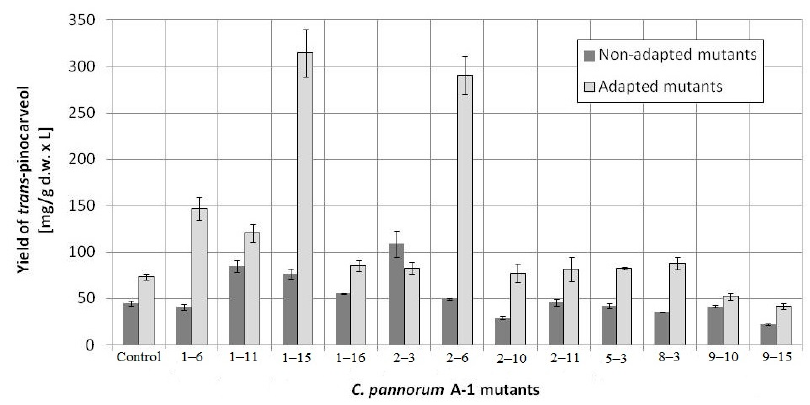
Figure 2 . Effect of mutagenesis and adaptation to the substrate β -pinene on the biotransformation yield of 12 most active mutants of C. pannorum A-1. Non-treated parental strain and parental strain adapted to pinene were used as controls.